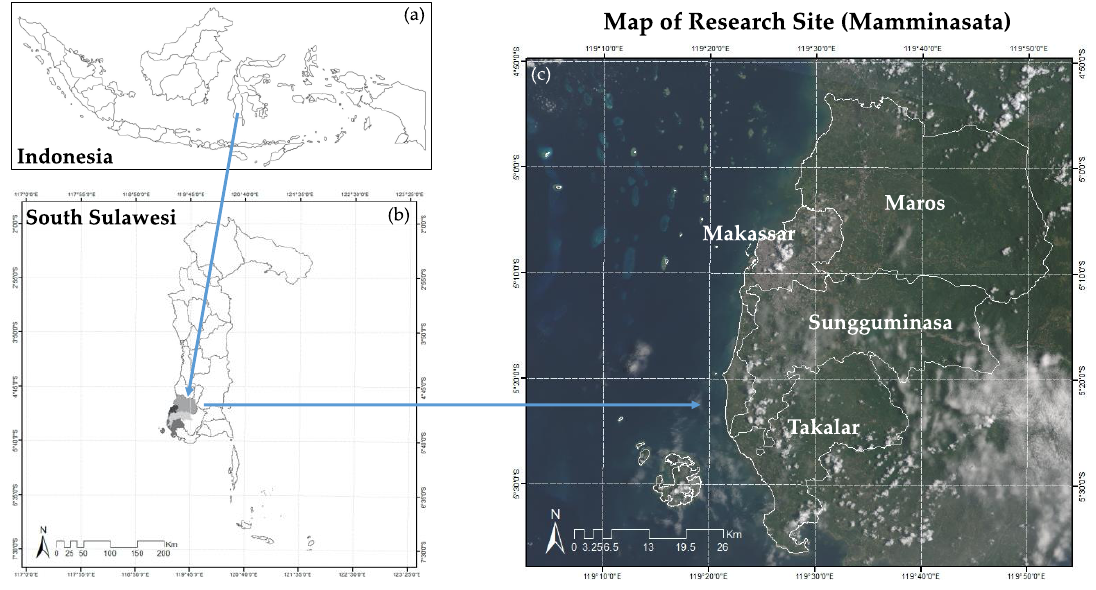
Figure 1. Research site: ( a ) Indonesia; ( b ) South Sulawesi province; ( c ) Mamminasata area.